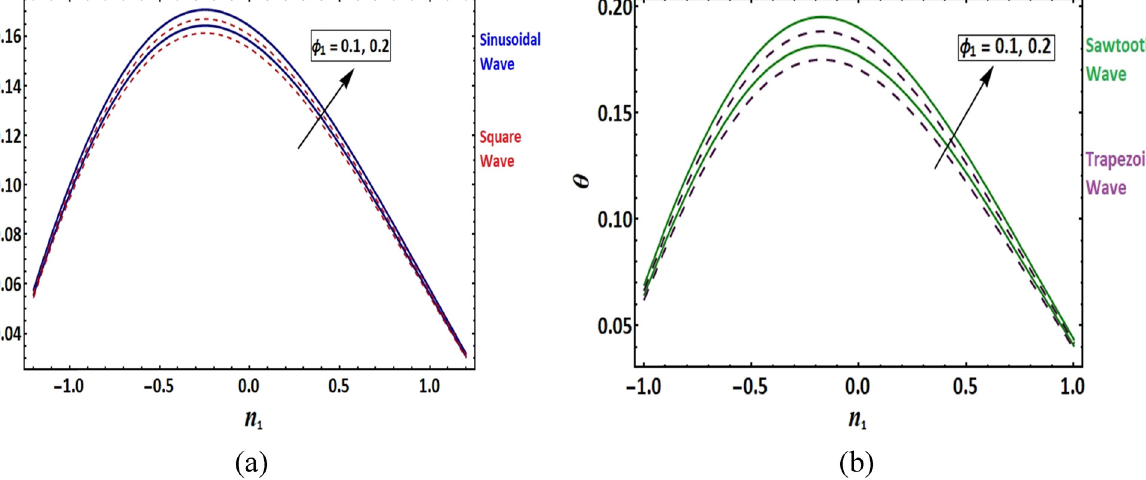
Figure 12: ( aandb ) Temperaturepro fi lefor λ 1 = 0.5, M = 0.2,Sc = 0.5, Gr = 0.4, A 1 = 2,Sr = 0.5 A 3 = 1,Br = 0.5, K 3 = 2, K = 3, ϵ 0.2 = , B 4 1 = ,and B 5 2 =